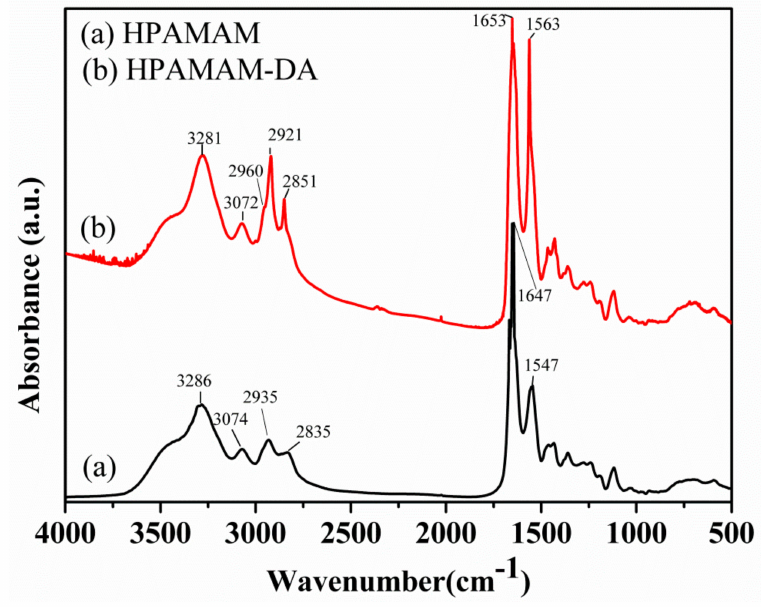
Figure 2. FTIR spectra of ( a ) HPAMAM and ( b )